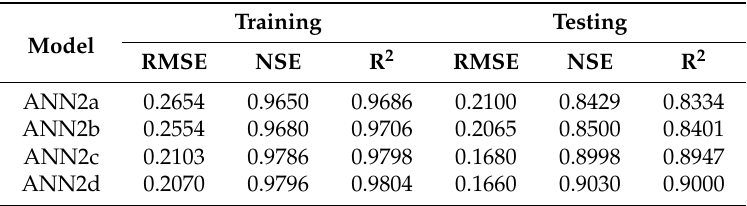
Table 7. Statistical measures of 2 h forecasts for 5% highest water level